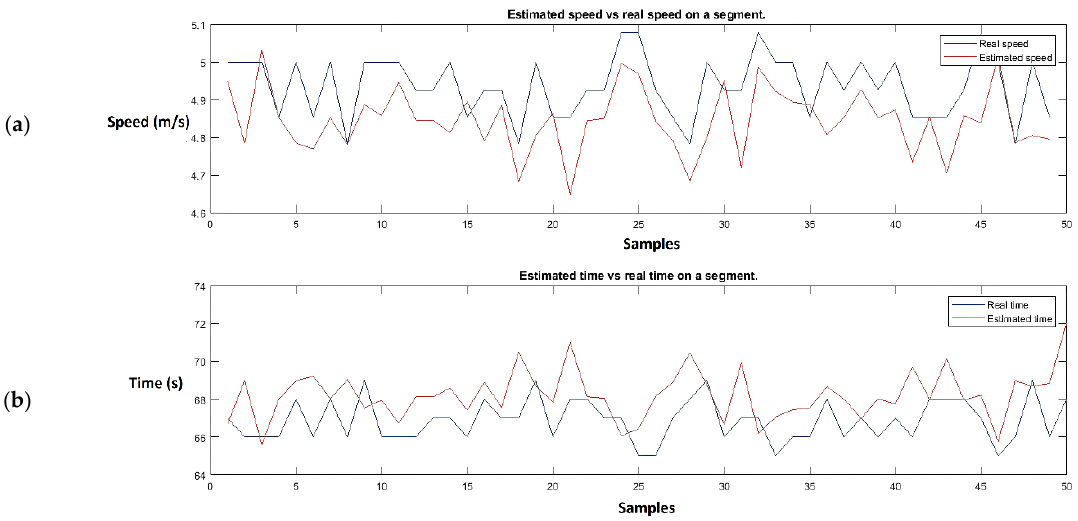
Figure 10. Linear prediction considering 50 trips and 50 previous samples: ( a ) real speed vs. estimated speed; ( b ) real time vs. estimated time.